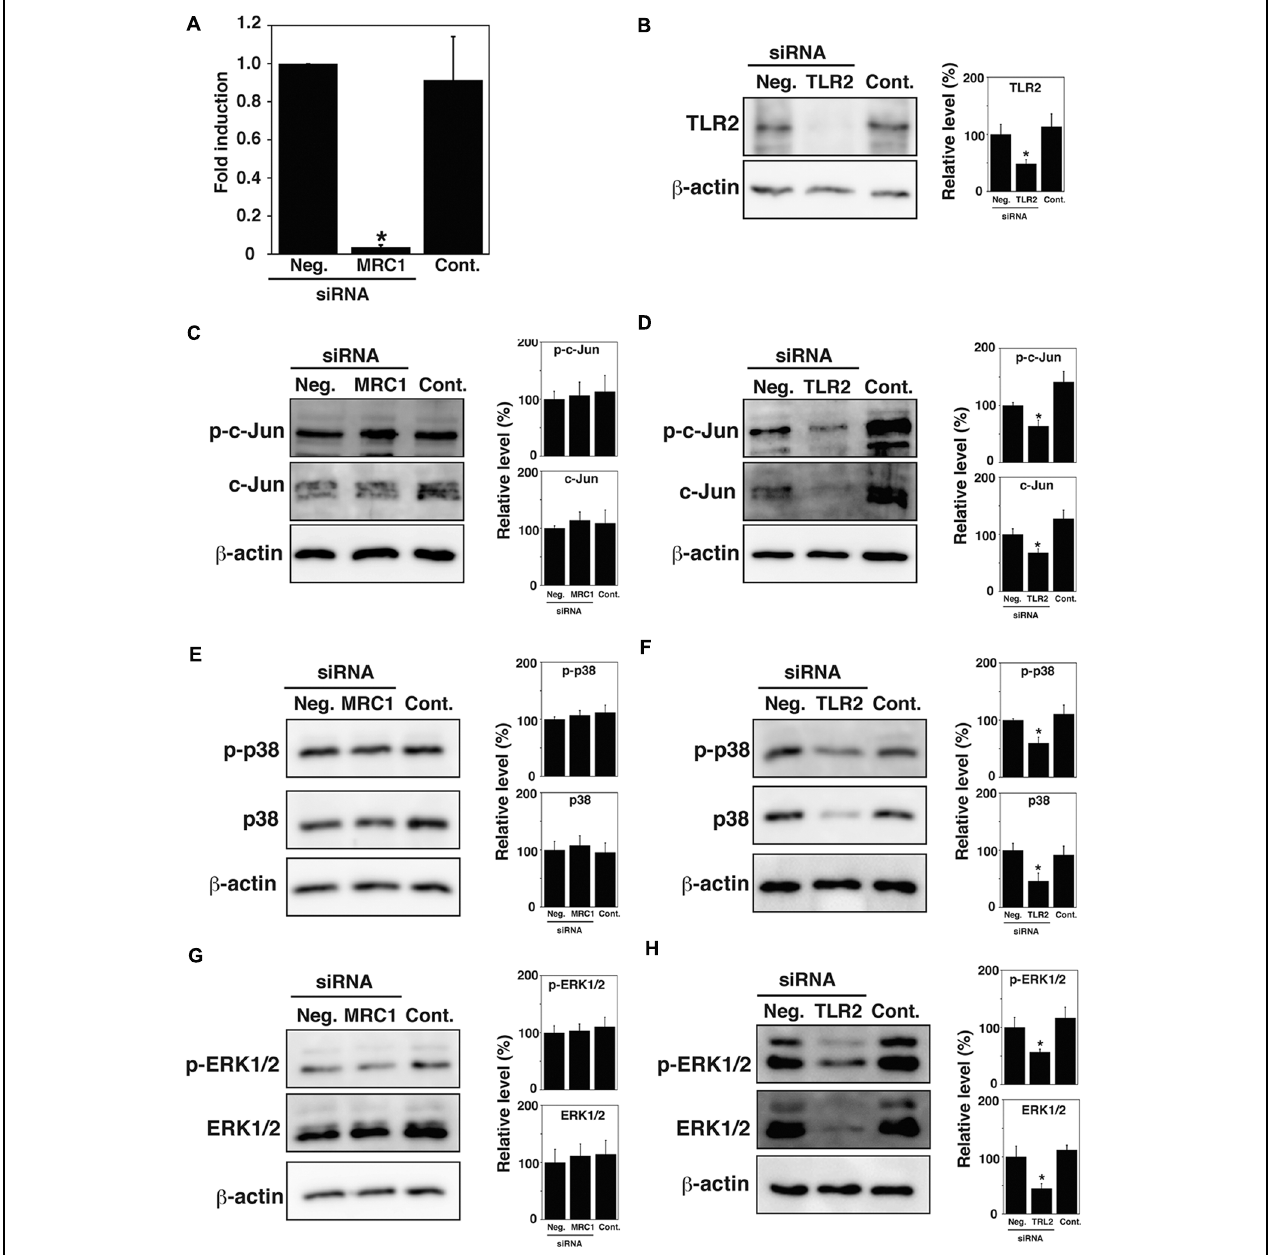
FIGURE 4 | Expression of MAPK family proteins in MRC1 and TLR2 knock-down TG cells. (A,B) Expression of MRC1 and TLR2. TG cells were treated for 48 h with or without (Cont.) siRNA-targeting MRC1 (A) or TLR2 (B) . AllStars Negative Control siRNA (Neg.) was used for a negative control. Production of the indicated proteins was monitored by qPCR (A) or immunoblotting (B) . β -actin was used as a control. (C,D) Detection of c-Jun and phosphorylated c-Jun (p-c-Jun) in MRC1 (C) or TLR2 (D) knock-down TG cells by immunoblotting. (E,F) Detection of p38 and phosphorylated p38 (p-p38) in MRC1 (E) or TLR2 (F) knock-down TG cells by immunoblotting. (G,H) Detection of ERK1/2 and phosphorylated ERK1/2 (p-ERK1/2) in MRC1 (G) or TLR2 (H) knock-downed TG cells by immunoblotting. (B–H) The intensity levels of each protein expression were measured using Multi gauge software and normalized by the value of β -actin. Relative values to the intensity of Neg. were shown. (A–H) All values represent the means and SD of three assays. ∗ P < 0.05 compared with Neg. by post hoc Tukey–Kramer test.